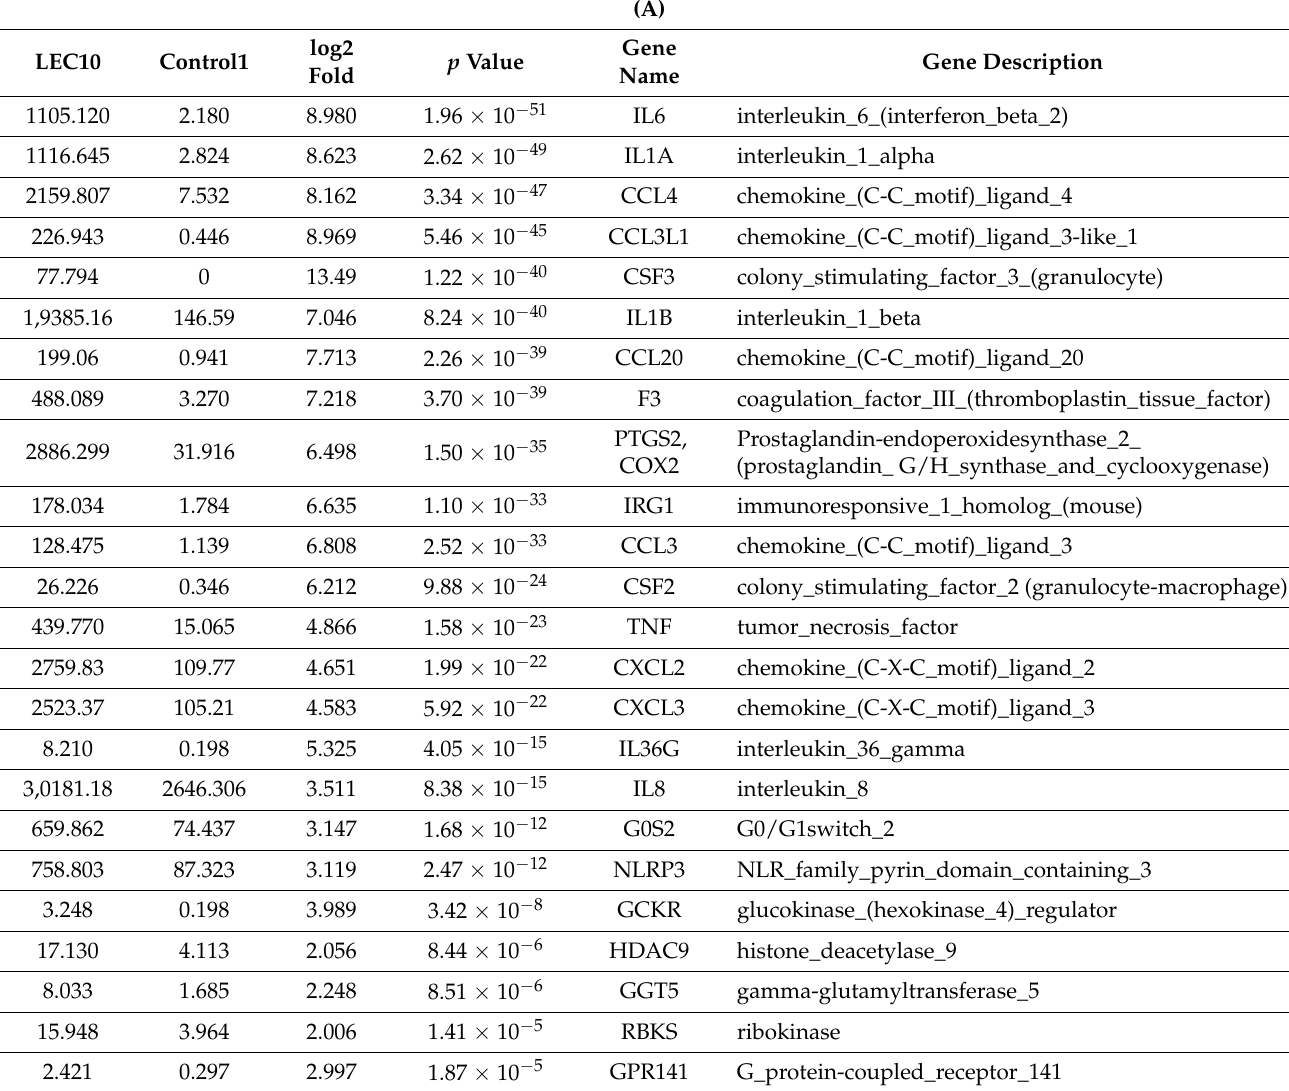
Table 3. ( A ) Genes upregulated by LEC 10 alone *. ( B ) Genes not upregulated by LEC10 to the same extent as LPS *. * These data represent the genes that are upregulated by LEC10 alone as compared to a LPS control in PBMCs, incubated for 3 h. RNA was extracted and subjected to RNAseq analysis. This data has been obtained by using the DEG program. ( C ) Genes that are upregulated by LPS, LEC10, LEC10 + LPS, LEC50 and LEC50 + LPS